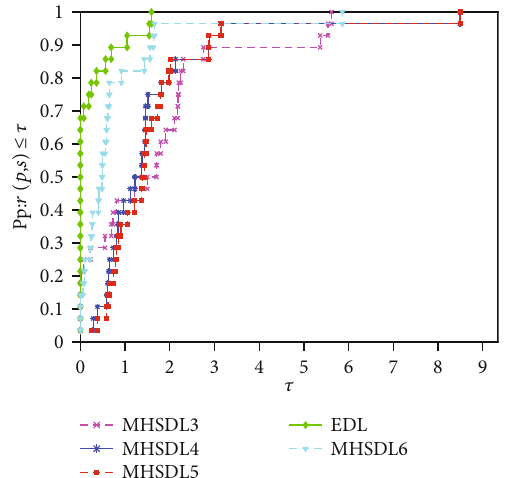
Figure 2: NFE performance pro fi le for EDL, MHSDL3, MHSDL4, MHSDL5, and MHSDL6 methods.